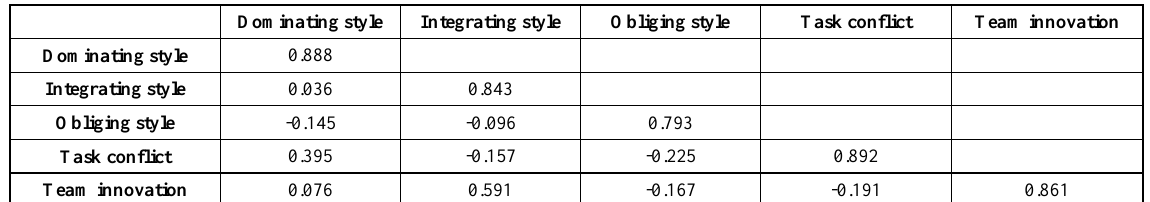
Table 2. Fornell-Larcker criterion.